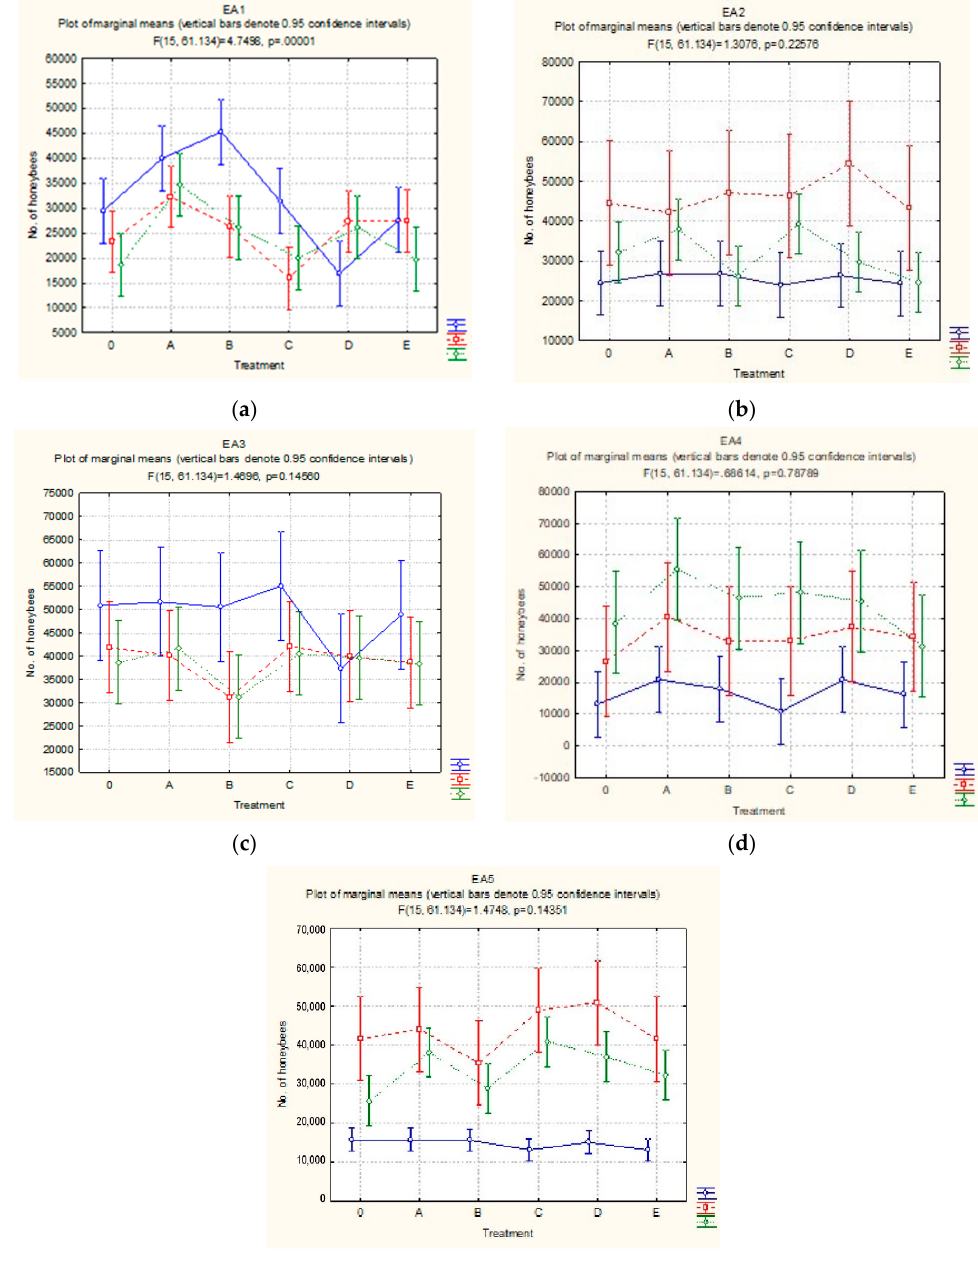
Figure 2 . Honey bee colony strength differences between experimental and control groups by different estimation dates (I—blue lines, II—red lines, III—green lines) at five apiary locations: ( a ) EA1, ( b ) EA2, ( c ) EA3, ( d ) EA4, ( e ) EA5.